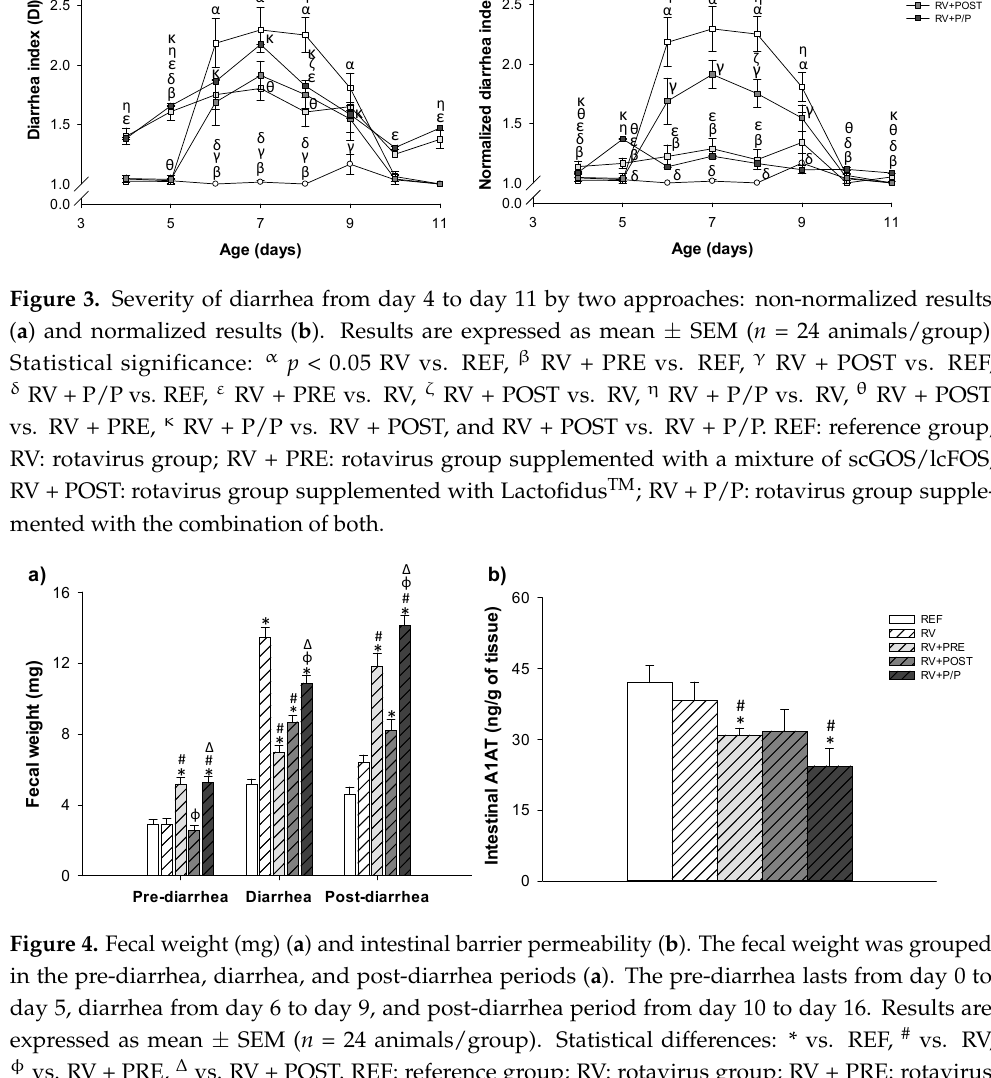
Figure 3. Severity of diarrhea from day 4 to day 11 by two approaches: non-normalized results ( a ) and normalized results ( b ). Results are expressed as mean ± SEM ( n = 24 animals/group). Statistical